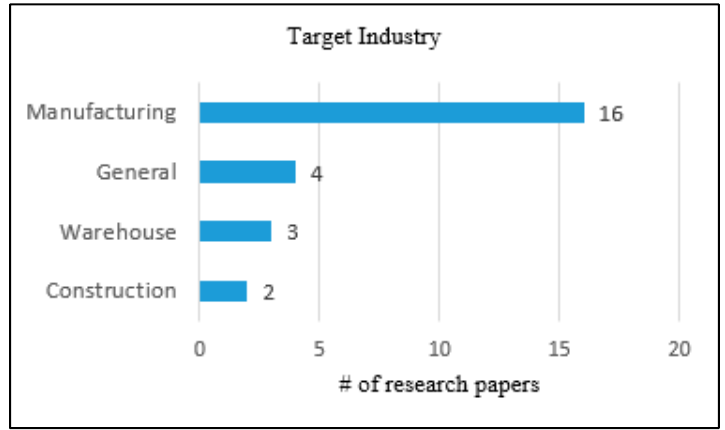
Figure 6. Target industries of existing applications.